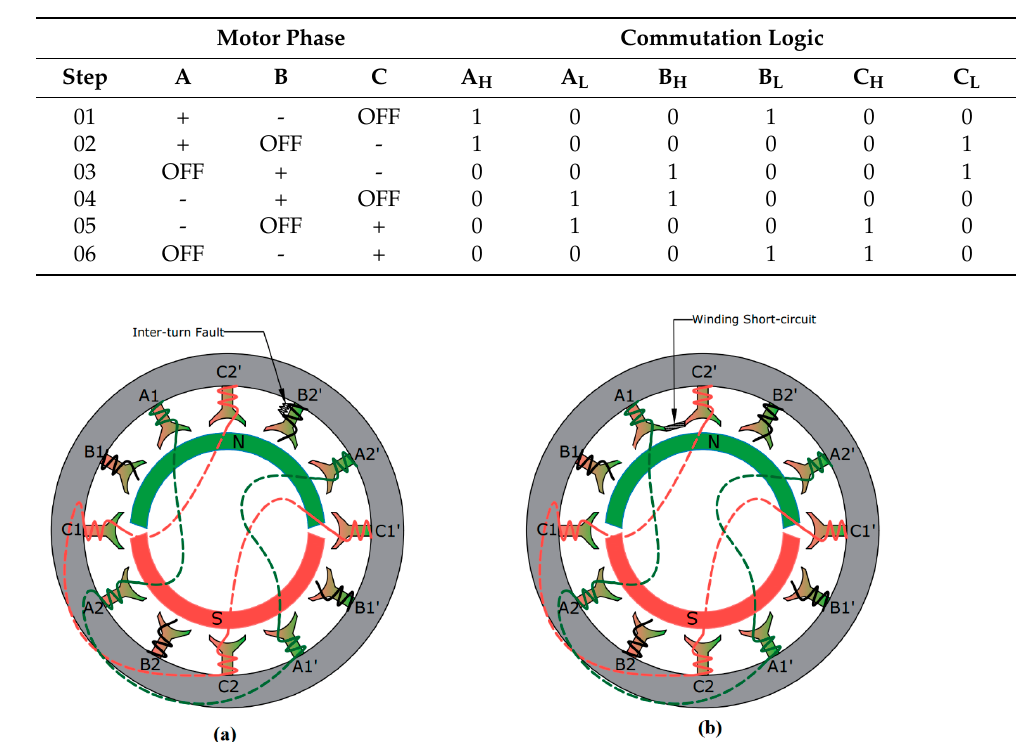
Table 2. Commutation of BLDC Motor.